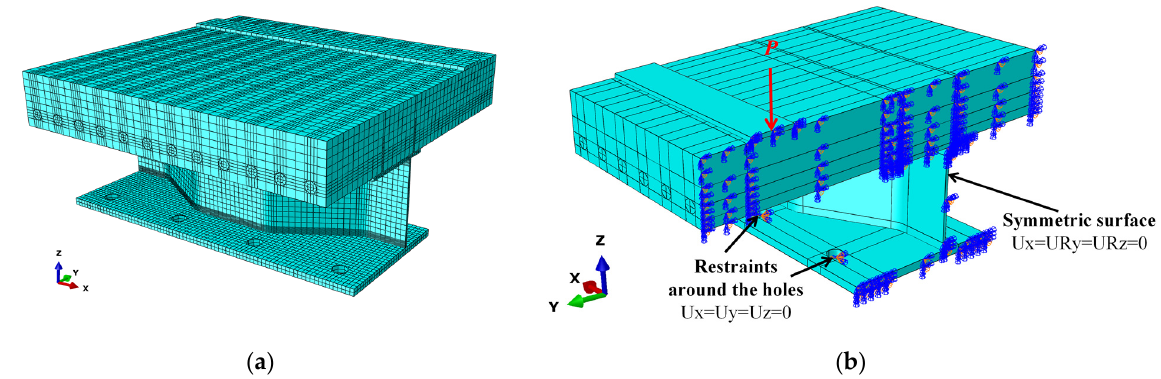
Figure 13. FE model: ( a ) mesh division; ( b ) boundary condition.